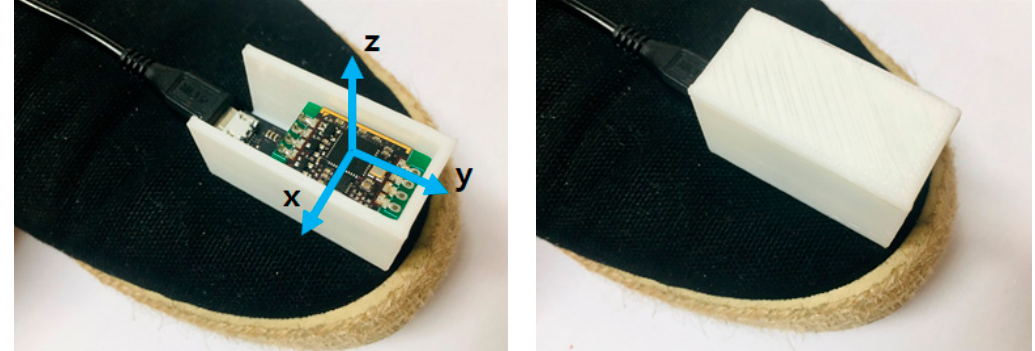
Figure 3. The inertial sensors, in a case made with a 3D printer, are attached to the shoe’s tip.